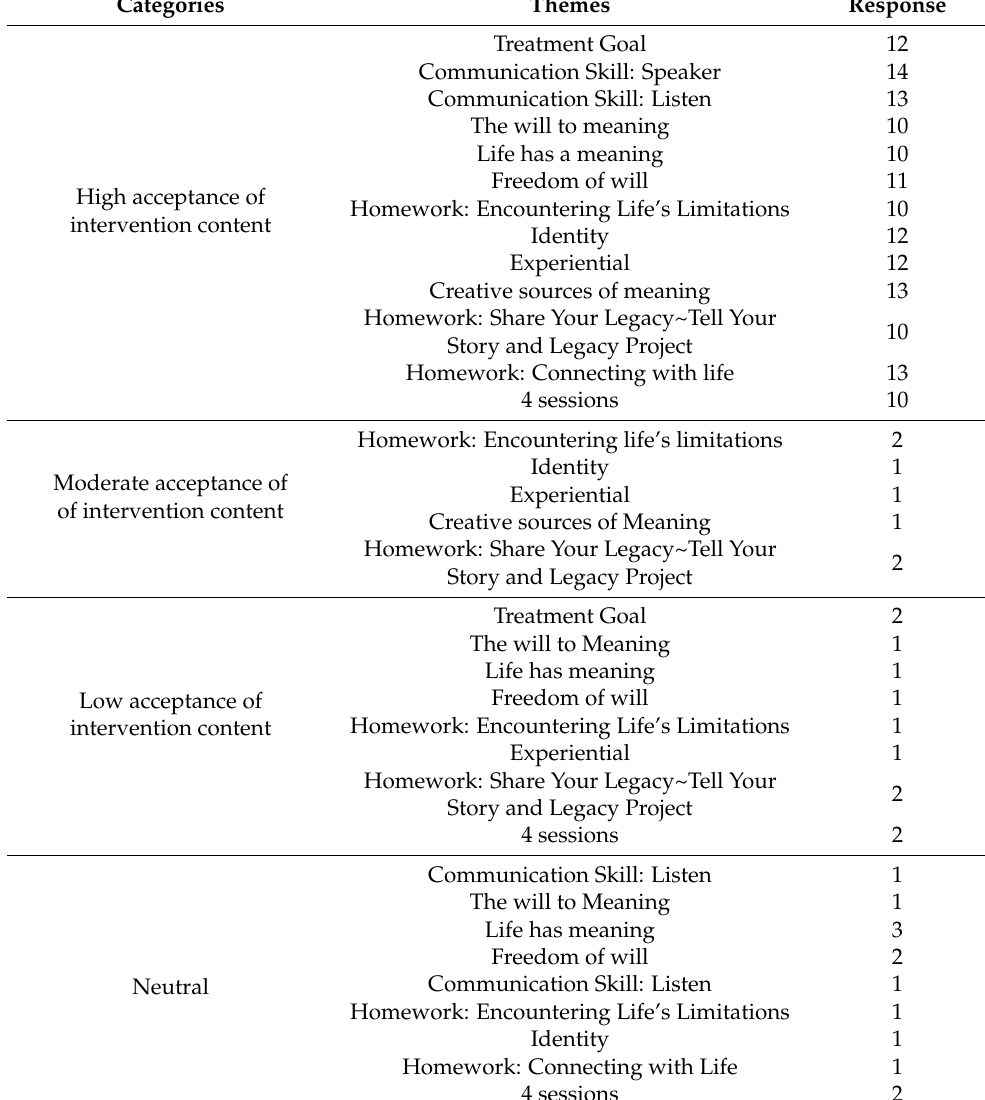
Table 3. High, moderate, low, and neutral acceptance of the intervention.